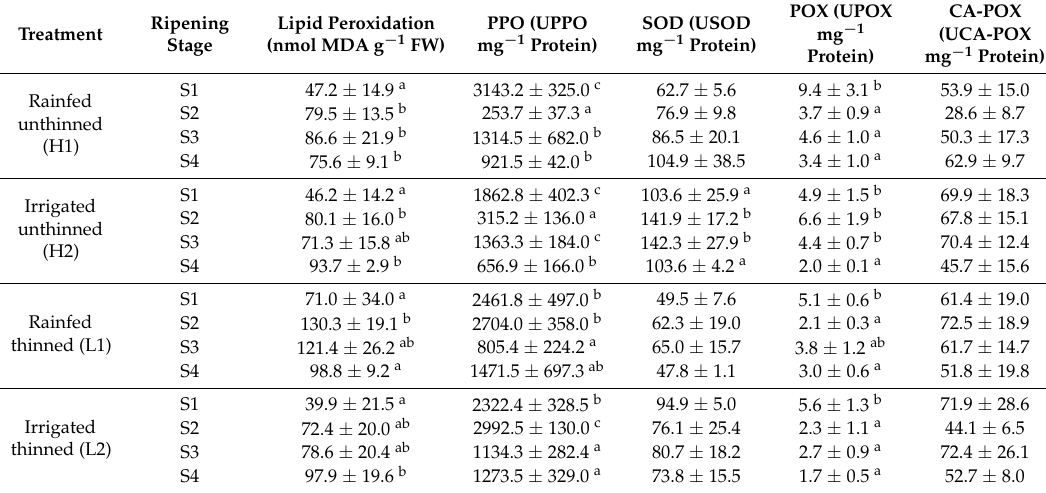
Table 2. Lipid peroxidation, and the polyphenol oxidase (PPO), superoxide dismutase (SOD), nonspecific peroxidase (POX), and coniferyl alcohol peroxidase (CA-POX) activities in the different treatments and ripening stages used. Data are the means ± SD of at least 10 replicates obtained from 5 different experiments. The values were subjected to the Friedman